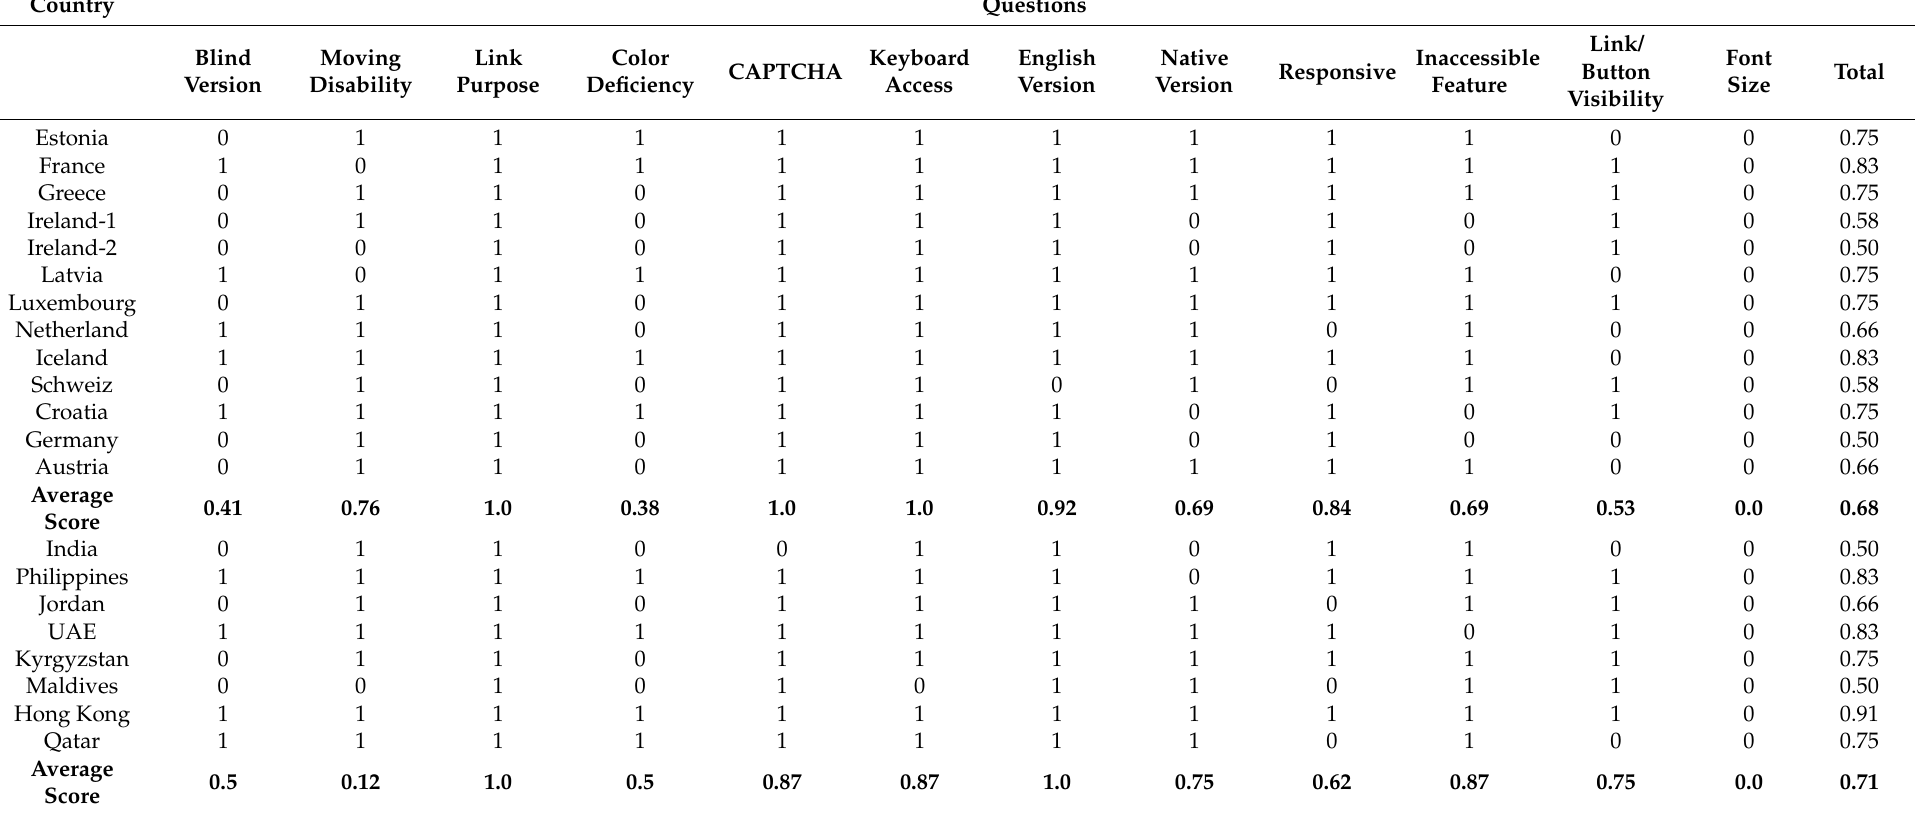
Table 14. Expert questionnaire-based websites requirements and accessibility